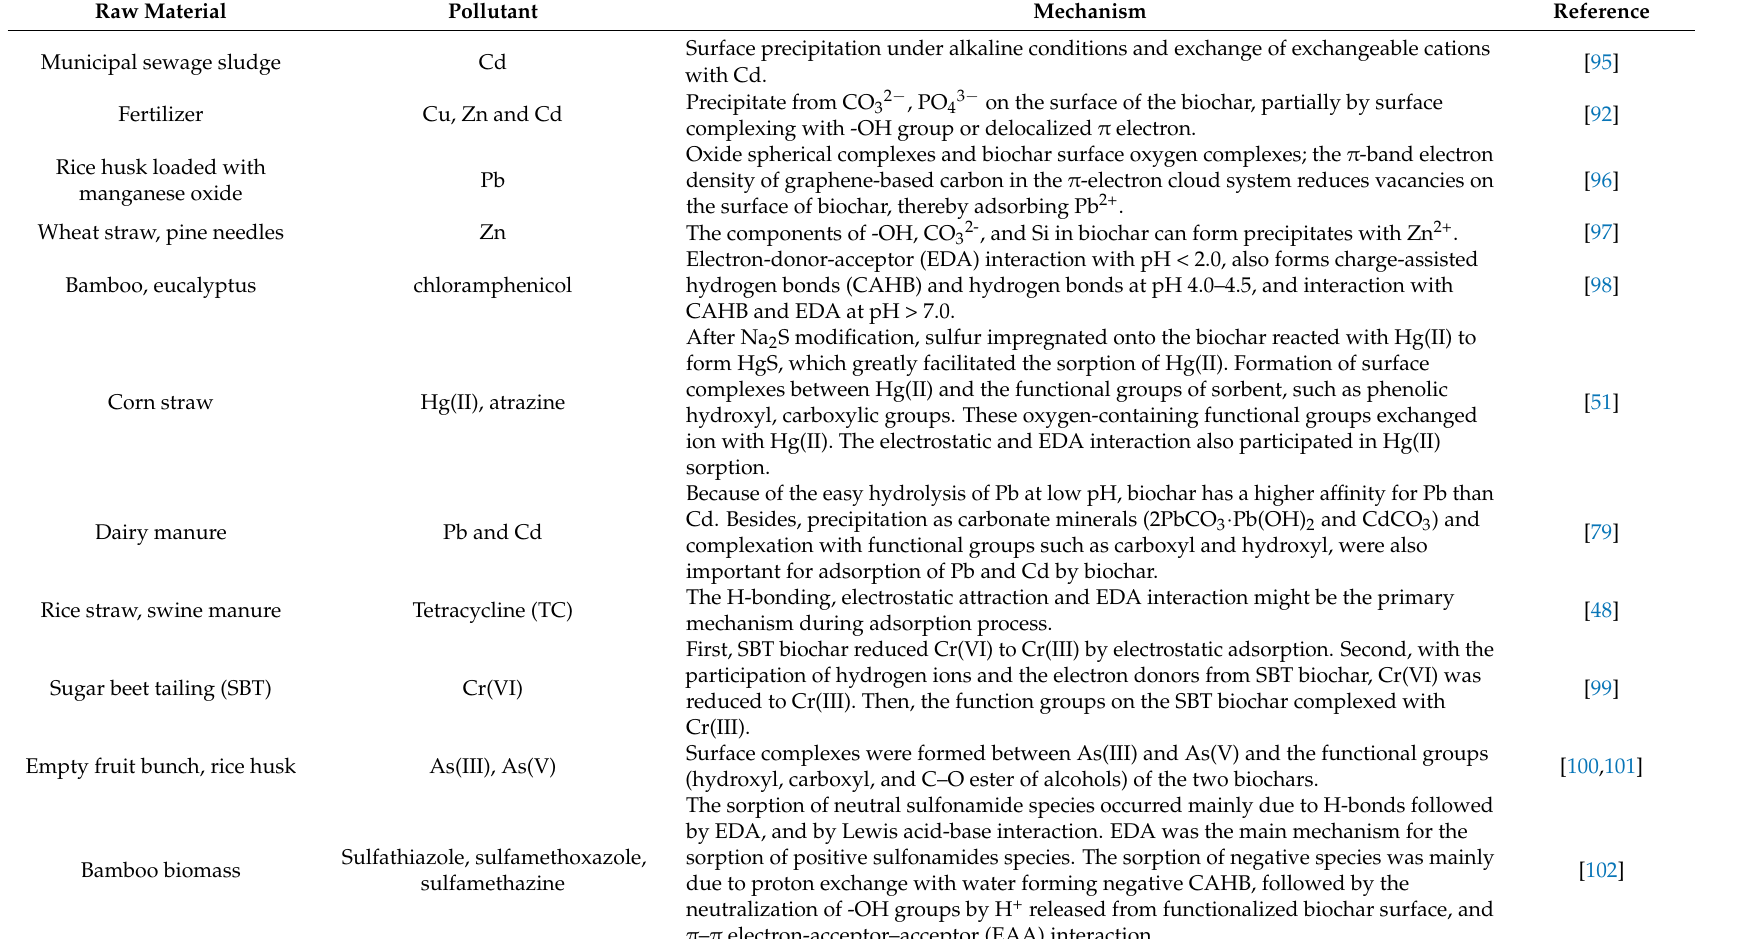
Table 3. Adsorption mechanism of biochar for pollution